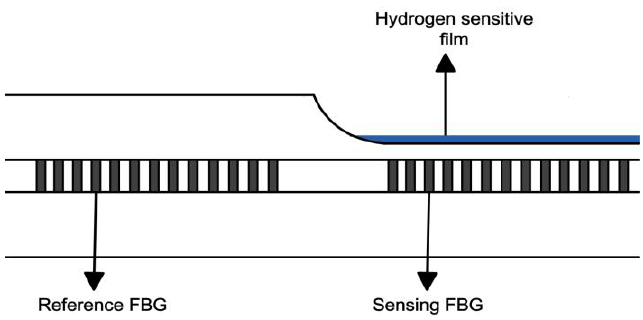
F igure 5. Typical structure of SPFBG hydrogen sensor [31]. Figure 5. Typical structure of SPFBG hydrogen sensor [31].